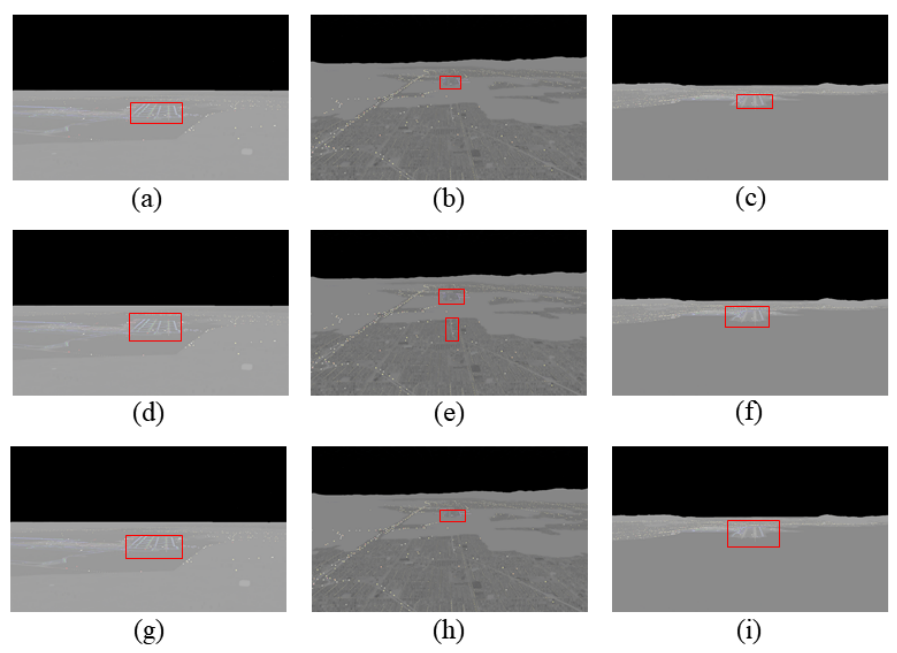
Figure 27. Detection results of three